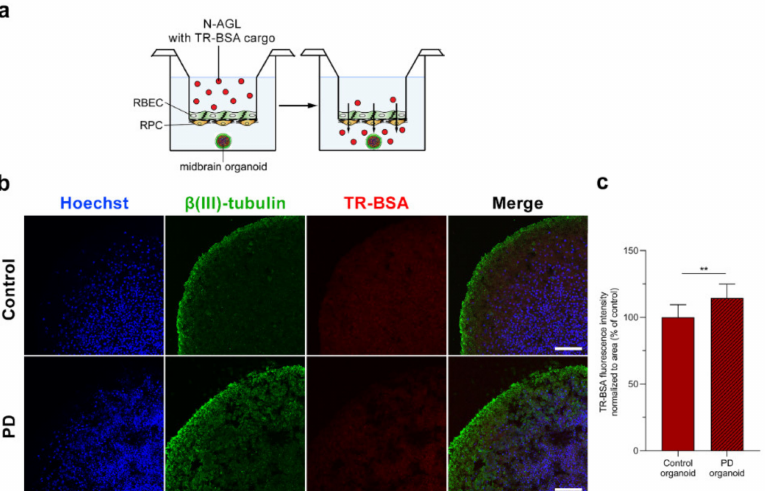
Figure 7. Entry of ascorbic acid-glutathione-leucine-targeted, Texas Red-BSA (TR-BSA; red) loaded nanoparticles (N-AGL) into midbrain organoids after passage across the BBB model. ( a ) Schematic drawing of the experiment. ( b ) Representative confocal microscopy images of midbrain-specific organoids derived from Parkinson’s disease patients (PD) and healthy control (Control). Neurons were immunostained with β III-tubulin (green), and cell nuclei were stained with bis-benzimide (blue). Bar: 100 µ m. ( c ) Fluorescence intensity evaluation of the red channel of the images of control and PD midbrain-like organoids indicating TR-BSA entry. Values presented are means ± SD and are given as arbitrary units (a.u.). Statistical analysis: Student’s t -test; ** p < 0.01, n =